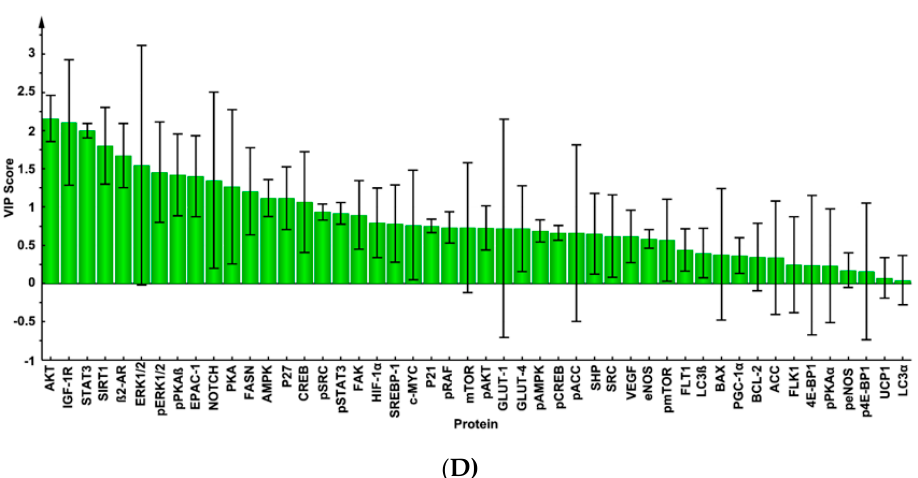
Figure 3. Analysis of protein expression in the mammary carcinoma using a supervised clustering algorithm. Effects of high (HIAC) or low (LIAC) inherent aerobic running capacity on patterns of protein expression in the mammary carcinoma ( n = 3/group) were assessed by multivariate discriminant analysis. Initially, inherent clustering patterns were determined by unsupervised analysis through principle component analysis (PCA) and complete separation of treatment groups was observed. ( A ) To determine contributing sources of variation, the scatter plot represents supervised analysis of the 2-class Orthogonal Projections to Latent Structures for Discriminant Analysis (OPLS-DA) model, which rotates the model plane to maximize separation due to class assignment. Complete separation of the two classes was observed. The circle on the graph is the 95% confidence ellipse for the OPLS-DA analysis; it was computed by the SIMCA software that was used for the analysis based on the Hotelling T 2 statistic discriminant model. Samples lying outside the 95% confidence interval are considered outliers; ( B ) to determine the proteins responsible for class separation multivariate analysis was used to construct a biplot that identified influential proteins responsible for the separation between classes. The circles on the plot are graphed by SIMCA to assist with the visualization of the location of scores and loadings at the 0.5, 0.75 and 1.0 coordinates on the X and Y axes; ( C ) an S-plot was constructed by plotting modeled correlation in the first predictive principal component against modeled correlation from the first predictive component. Upper right and lower left regions of S-plots contain candidate proteins with both high reliability and high magnitude discriminatory proteins; ( D ) to determine the statistical reliability of the effects, variable importance plots were generated in which jack-knifed confidence intervals (JKCI) were created on the magnitude of covariance in the first component for the analytes assessed. Proteins with JKCI including 0 were considered not to account for separation.